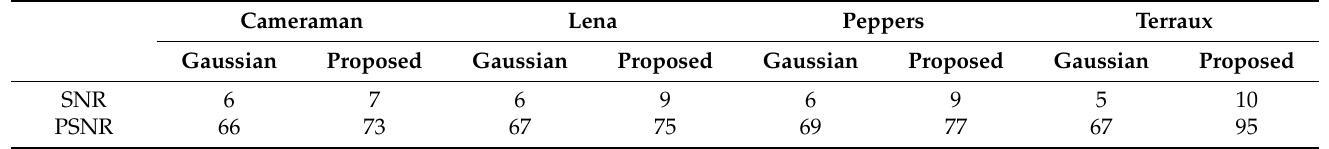
Table 1. Comparison of the PSNR and SNR of the two algorithms on four standard digital images.